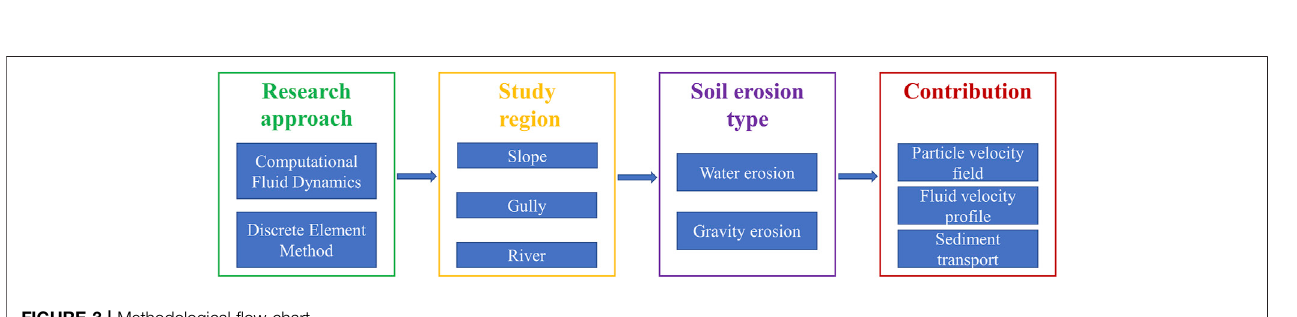
FIGURE 3 | Methodological fl ow chart.